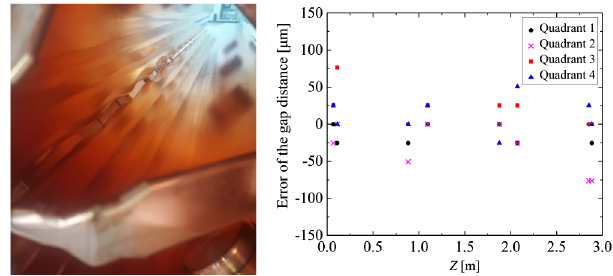
FIG. 15. Vane-tip gaps (left) and error of the gap distance between two adjacent vane tips in four quadrants (right) for the XiPAF